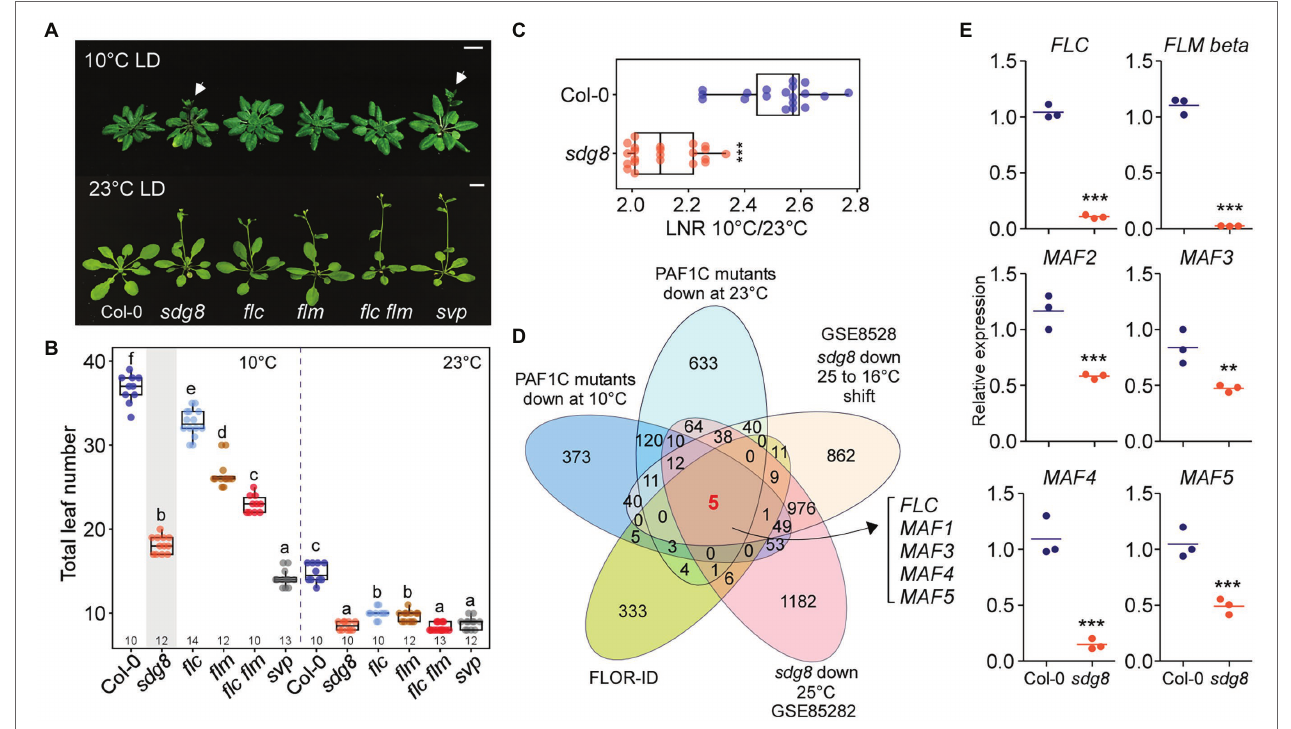
FIGURE 6 | MAF genes are important for floral repression at low temperature. (A,B) Flowering phenotype (A) and flowering time (B) of sdg8 , flc , flm , flc flm , and short vegetative phase ( svp ) mutants at 10 and 23 ° C under LD conditions. Arrows indicate inflorescences. (C) Leaf number ratio (LNR; 10 ° C/23 ° C) of sdg8 mutants. (D) Venn diagram of the genes that were commonly downregulated in sdg8 mutants and PAF1C-deficient mutants at different temperatures. (E) Reverse transcription quantitative PCR (RT-qPCR) of FLC and FLC -clade genes in the wild type (Col-0) and sdg8 mutants at 10 ° C under LD conditions. One-way ANOVA followed by Dunnett’s multiple comparison tests were performed to test the statistical significance. * p < 0.05; ** p < 0.01; *** p ≤ 0.001; and ns: not significant. Letters indicate significant differences by one-way ANOVA followed by Tukey’s range tests ( p < 0.05). Numbers above the x -axis in (B) represent n . Scale bar = 1